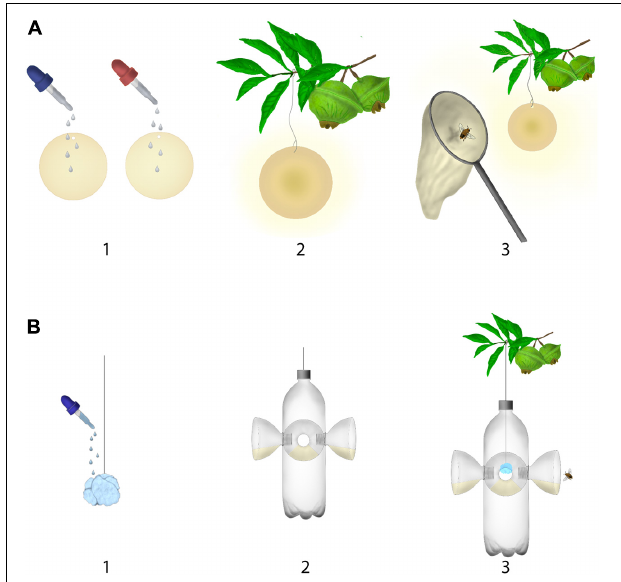
FIGURE 1 | Diagram of the active method (A) and passive (B) methods used to collect nocturnal bees with chemical compounds. We recommend the application of about 1 ml chemical compounds to filter paper or a cotton